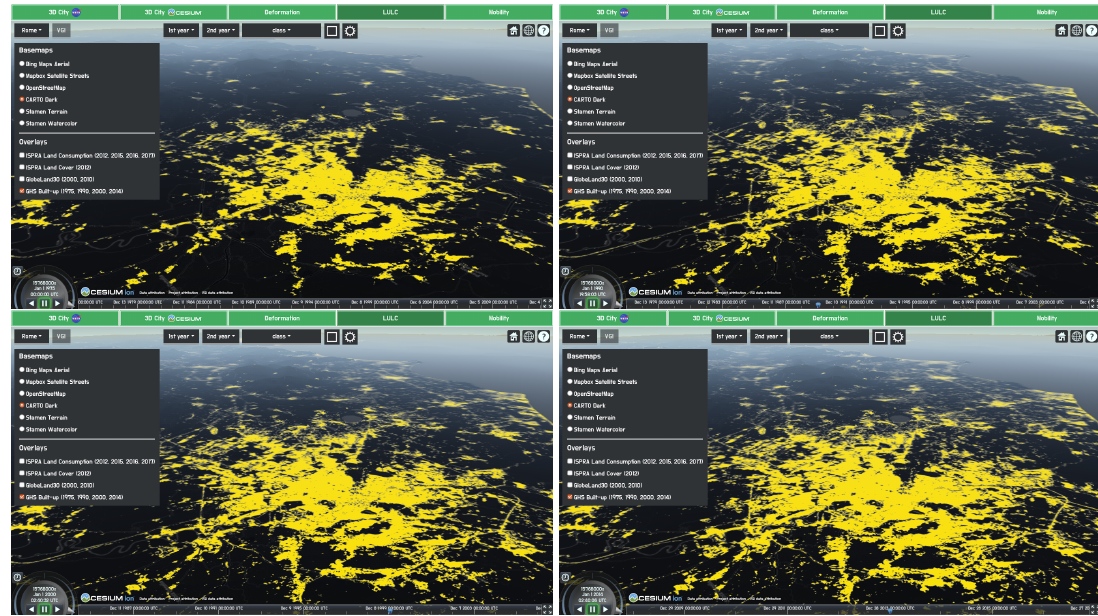
Figure 10. Visualization of GHS-BUILT zoomed on Rome of 1975, 1990, 2000 and 2014, in order from top-left to bottom-right, on a virtual globe created using